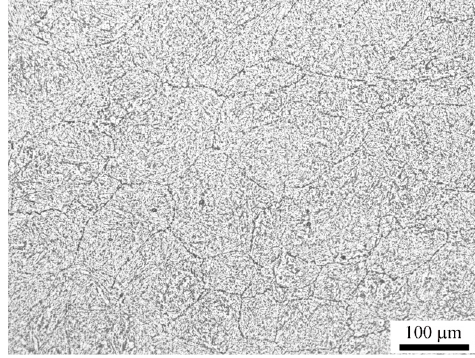
Figure 1. The homogeneous microstructure before hot deformation.